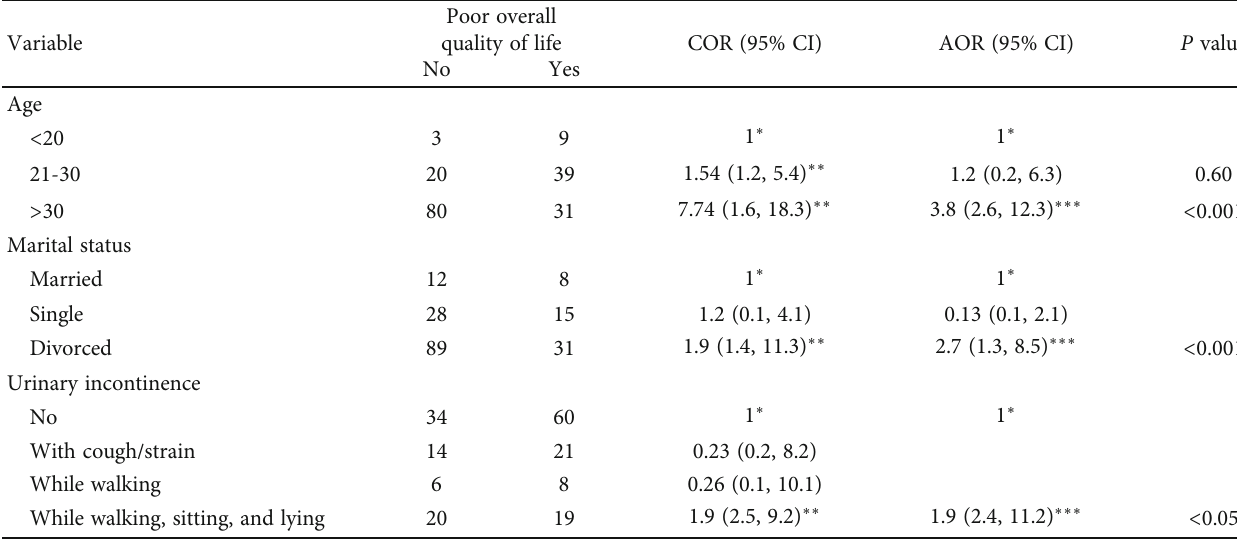
Table 4: Bivariable and multivariable analysis of factors associated with overall quality of life among fi stula survivors ( n = 182 ), central Gondar districts, Northwest Ethiopia, June 2020.